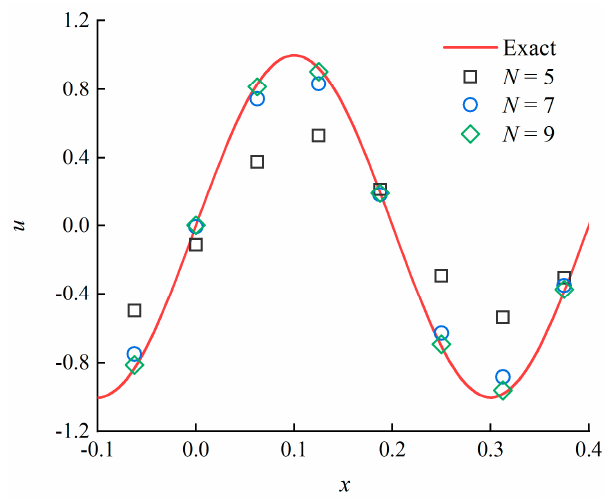
( b ) Figure 8. Dispersion coefficients against α in different wavelet schemes: ( a ) N ∈ odd; ( b ) N ∈ even. Table 4. The maximum α for the different schemes. N